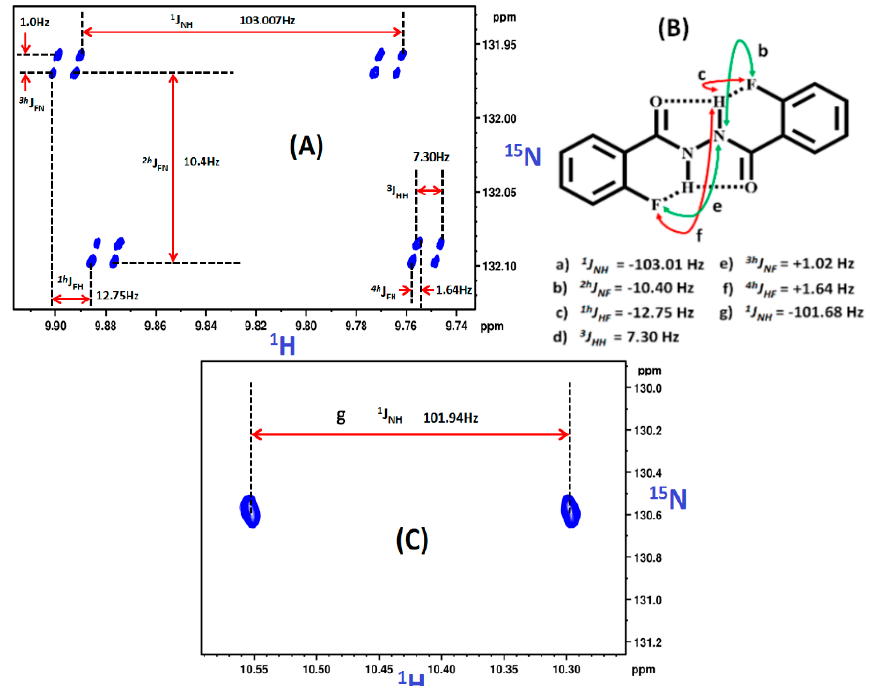
Figure 17. ( A ) 800 MHz 1 H- 15 N-HSQC (NH-coupled) spectrum of molecule 9 in CDCl 3 ; ( B ) the chemical structure of the molecule 9 with marking of couplings determined and their magnitudes; ( C ) 400 MHz 1 H- 15 N-HSQC spectrum (NH-coupled) in DMSO -d 6 .